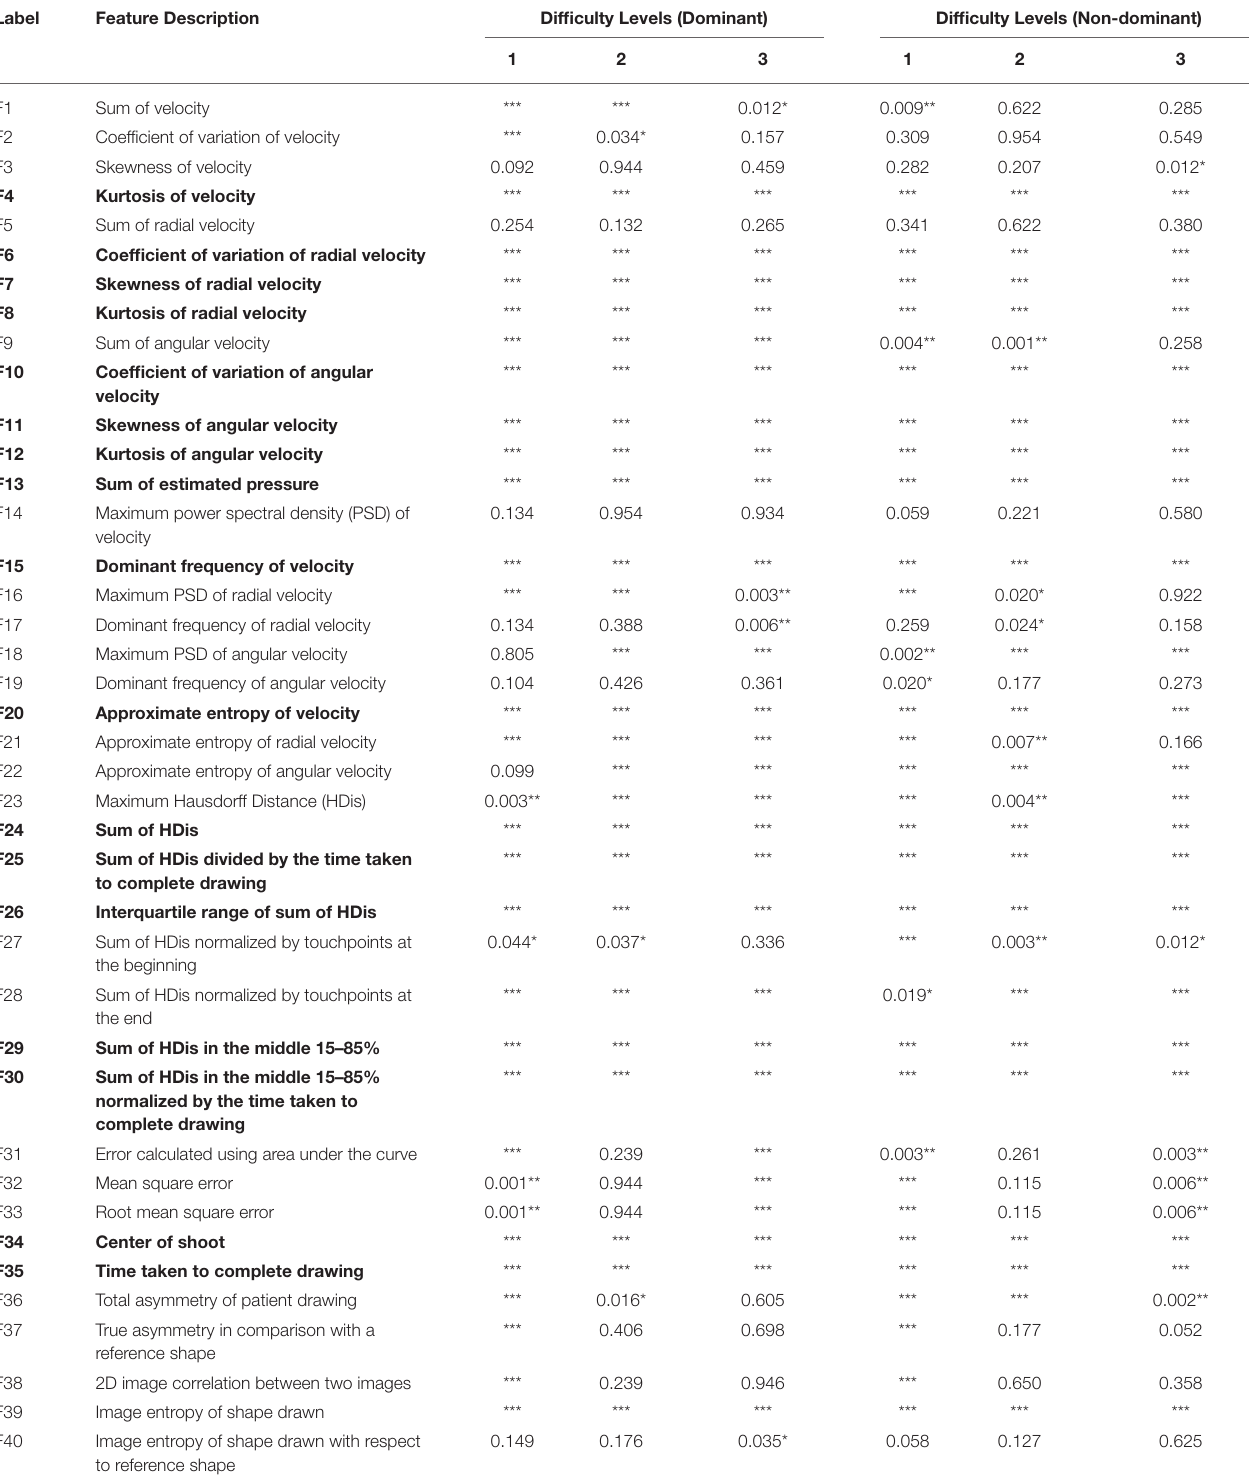
TABLE 3 | List of digital features relating to upper extremity function calculated from the spiral drawing